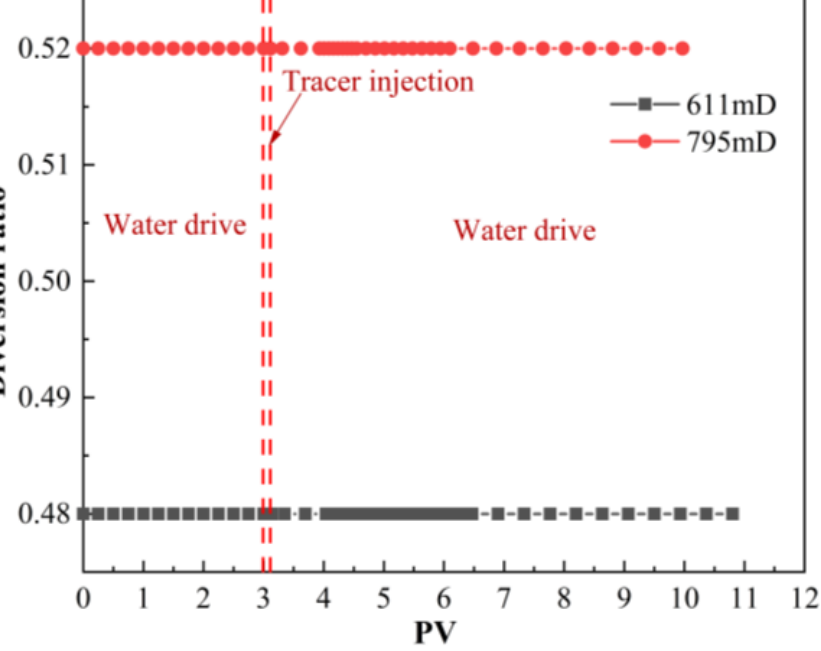
Figure 16. Relationship between shunt ratio and injection volume.